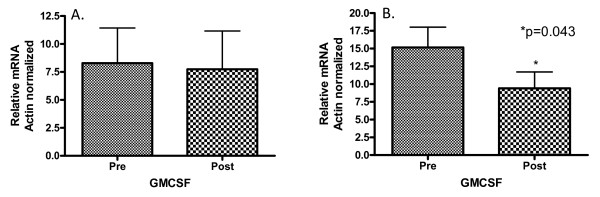
Panel A. Levels of γ-interferon mRNA following the administration of GM-CSF after chemotherapy. γ-interferon mRNA levels were measured in 16 patients pre-chemotherapy/GM-CSF administration and post-GM-CSF/chemotherapy administration by quantitative real time PCR of peripheral blood mononuclear cells. γ-interferon mRNA levels were normalized against the housekeeping gene β-actin mRNA. There was no statistically significant change between the two groups. Panel B. Levels of T-bet transcription factor mRNA following the administration of GM-CSF after chemotherapy. T-bet transcription factor mRNA levels were measured in 16 patients pre-chemotherapy/GM-CSF administration and post-GM-CSF/chemotherapy administration by quantitative real time PCR of peripheral blood mononuclear cells. T-bet transcription factor mRNA levels were normalized against the housekeeping gene β-actin mRNA. There was an approximate 1.7 fold decrease in T-bet transcription factor mRNA levels following the administration of GM-CSF after chemotherapy (p = 0.043). The statistical significance was determined by a Wilcoxin matched pairs test.